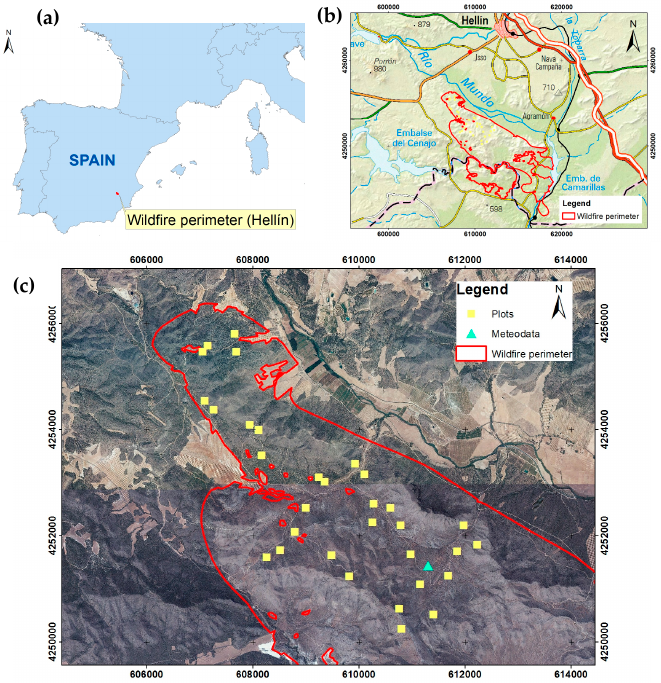
Figure 1. Maps of the study area and research site. The perimeter of the “Sierra de los Donceles” wildfire ( a : in Spain, and b : in the municipality of Hellín), automatic weather station (Meteodata) and experimental plots ( c ) are represented on the maps. UTM coordinates, ETRS89.